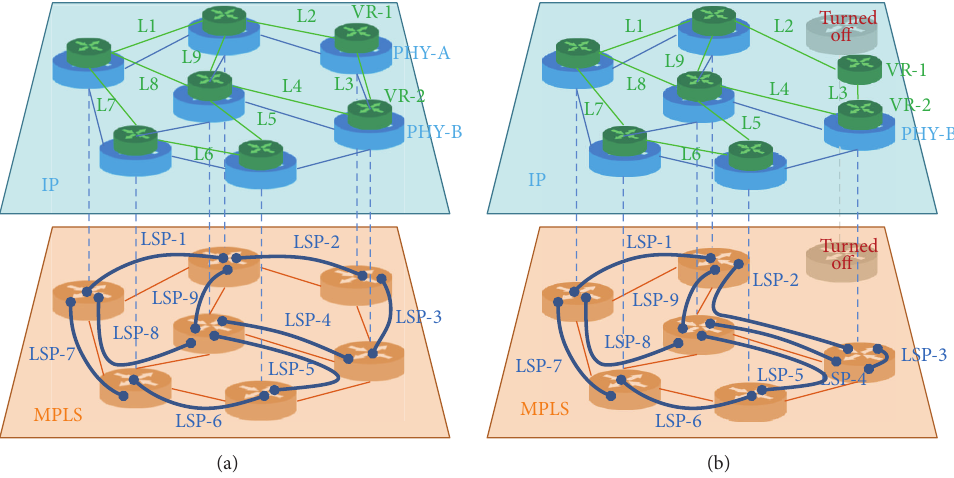
Figure 2: IP/MPLS network configuration before (a) and after (b) the migration of a virtual